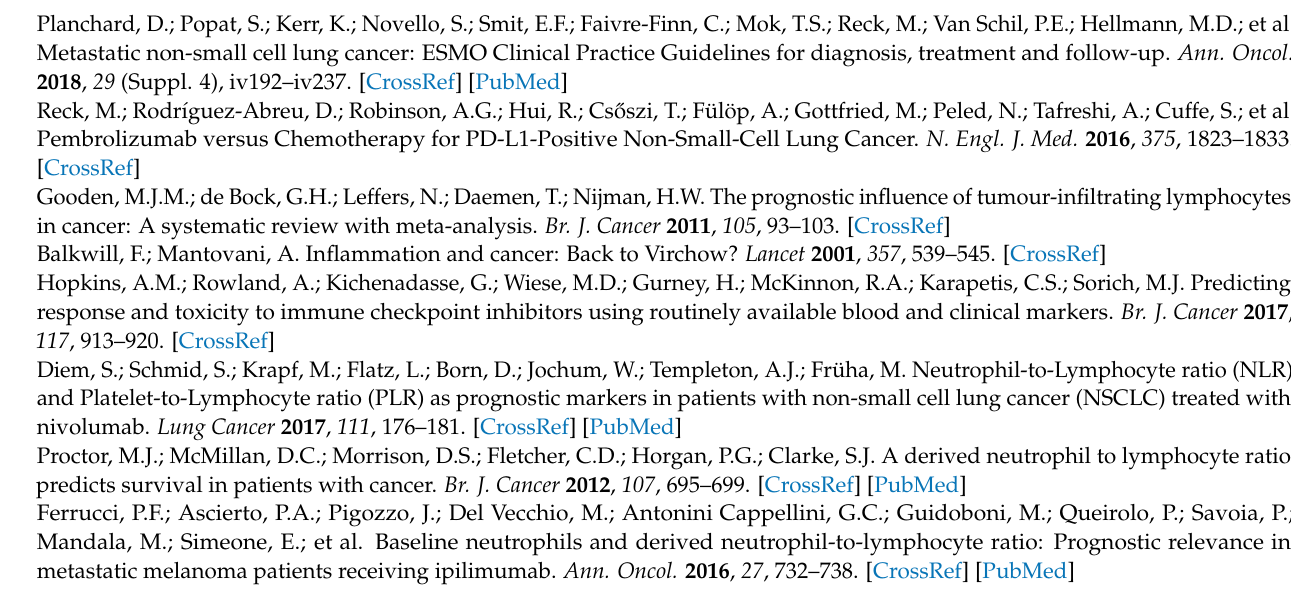
curves, Table S1: Blood counts at ICI treatment start, Table S2: Cox regression: progression-free survival, Table S3: Cox regression: overall